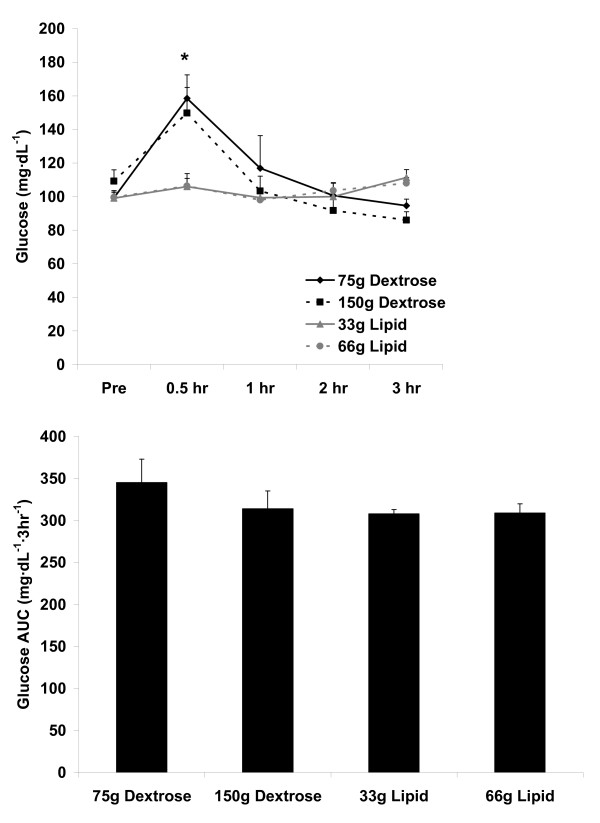
Blood glucose before and following the consumption of a dextrose or lipid meal in young healthy men. Data are mean ± SEM. Meal effect (p = 0.13). *Time effect (p < 0.0001); 0.5 hr > Pre, 1 hr, 2 hr, and 3 hr. Meal × Time effect (p = 0.0002). AUC effect (p = 0.44).